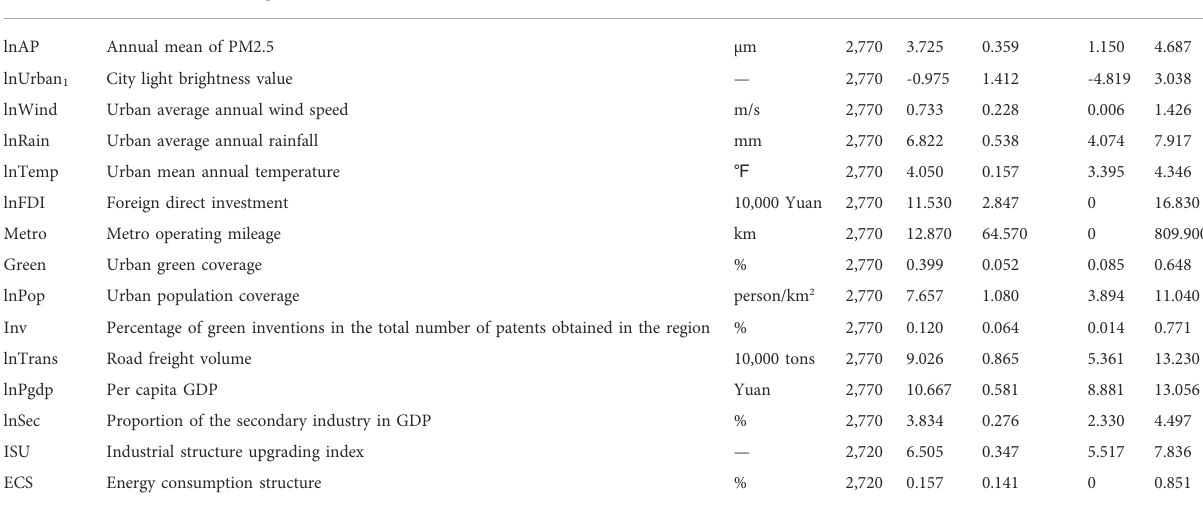
TABLE 1 Descriptive statistics of